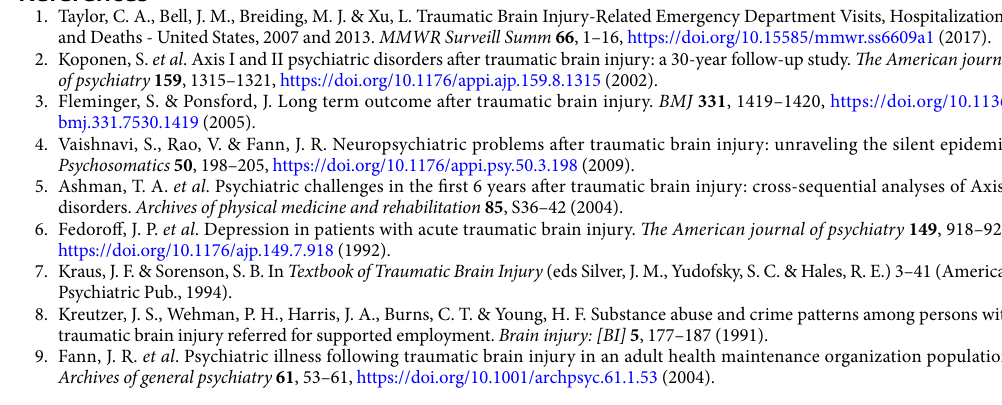
11 Scientific RepoRts | (2018) 8:9941 | DOI:10.1038/s41598-018-28062-0